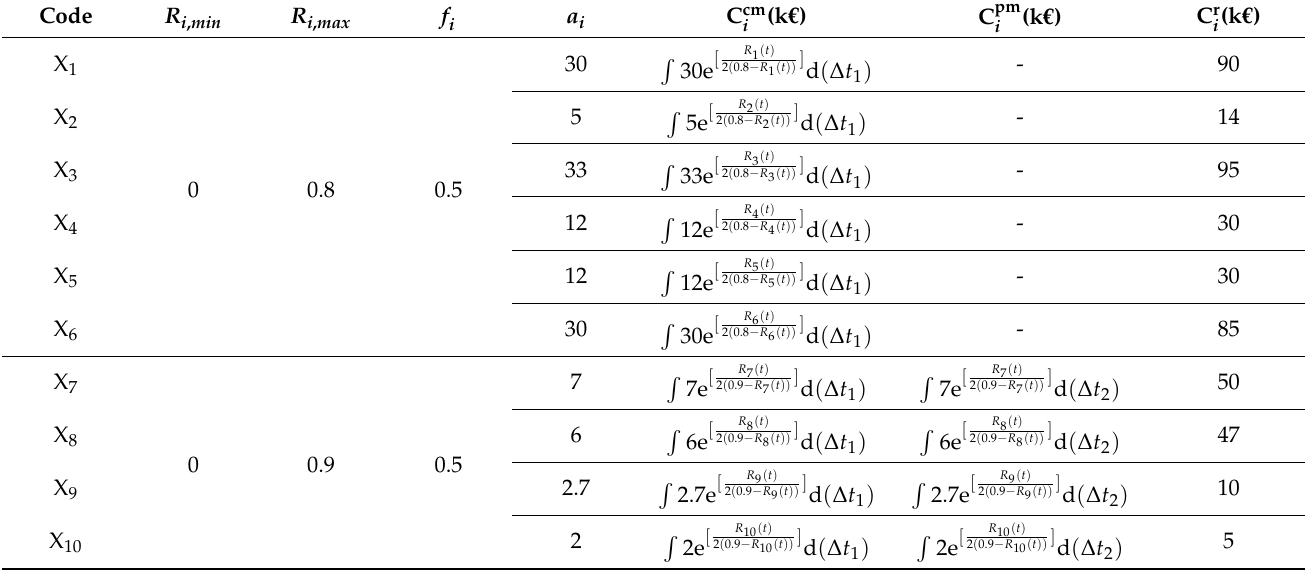
Table 4. The parameters and various costs of components.